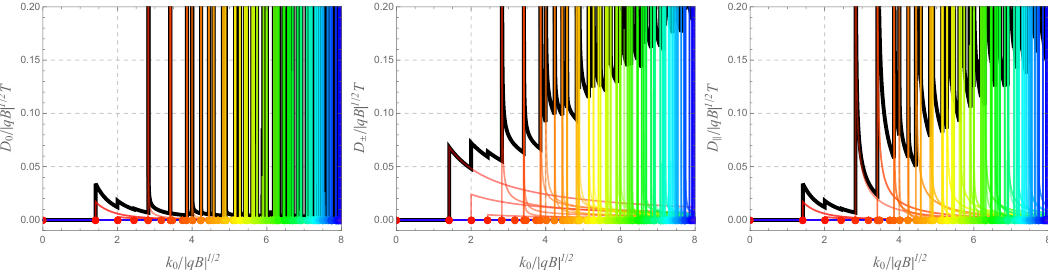
k = 3 , | k = 1 and k = 0 . The colored dots 0 /m ⊥ | /m z /m (4.13) in max . λ